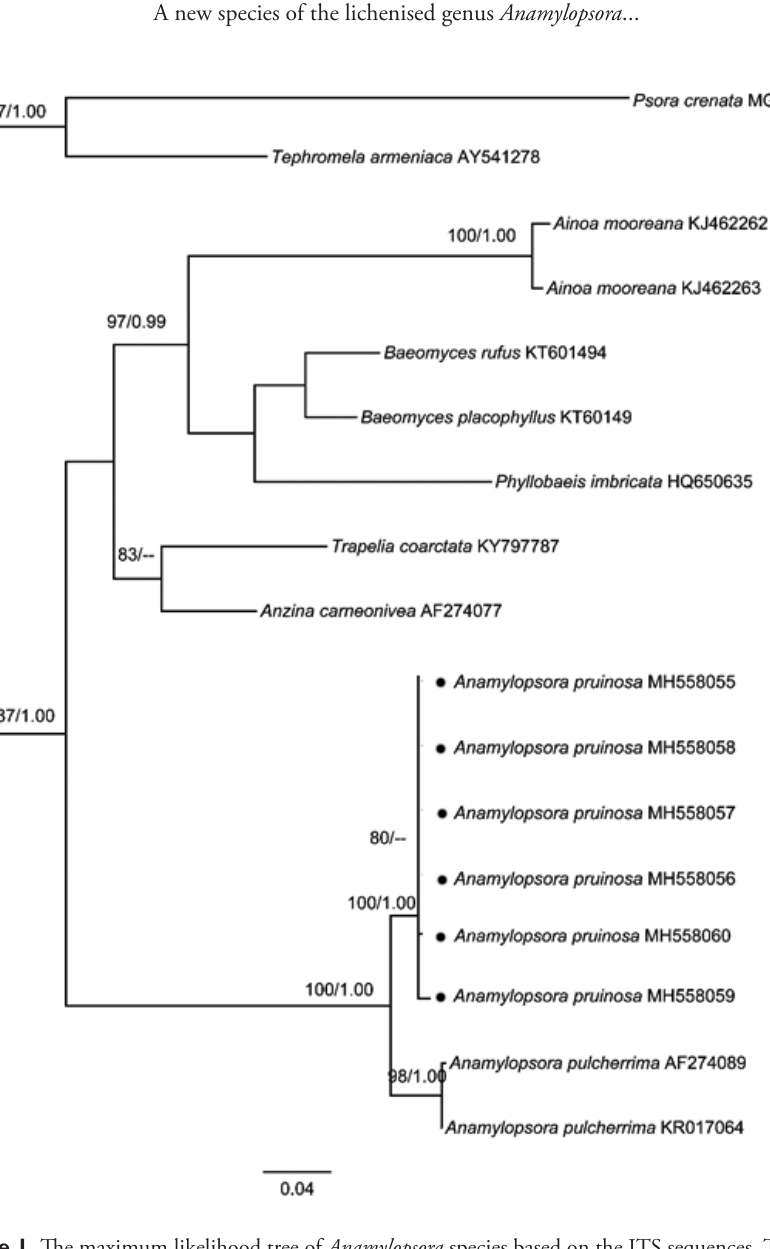
Figure 1. The maximum likelihood tree of Anamylopsora species based on the ITS sequences. The num- bers in each node represent bootstrap support (BS) and posterior probability (PP) values. Bootstrap values ≥ 75 and posterior probability values ≥ 0.95 were plotted on the branches of the RAxML tree. Except for the new species Anamylopsora pruinosa , marked by the solid circle ‘ ● ’, all the other sequences were down- loaded from GenBank. Scale bar: 0.04 substitution per